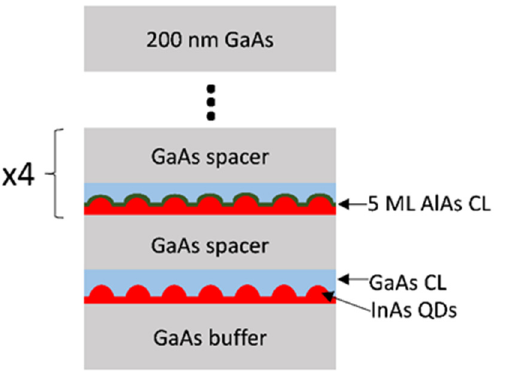
Figure 1. Scheme of the sample structure. The growth rate of the AlAs CLs increased in each layer, 0.25, 0.5, 0.75 and 1 ML/s, respectively.